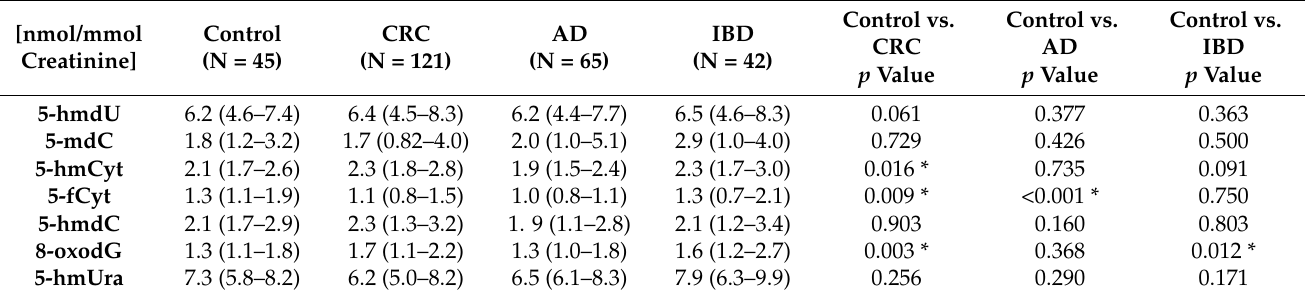
Table 1. Urinary levels of DNA damage markers and active demethylation products of 5- methylcytosine.